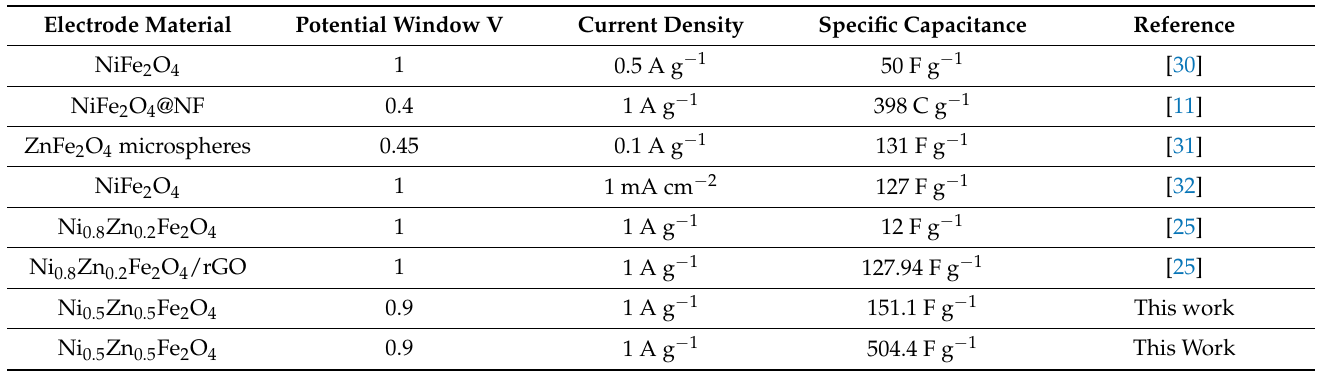
Table 1. Comparison of specific capacitance with the earlier reported